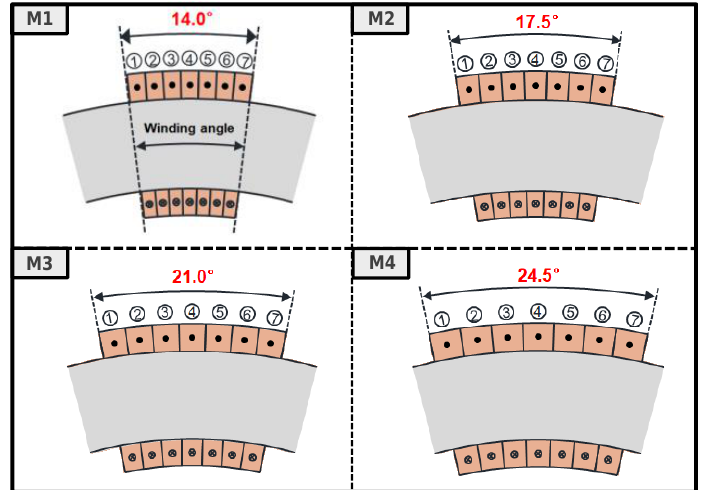
Figure 10. Coil shape according to winding angle.